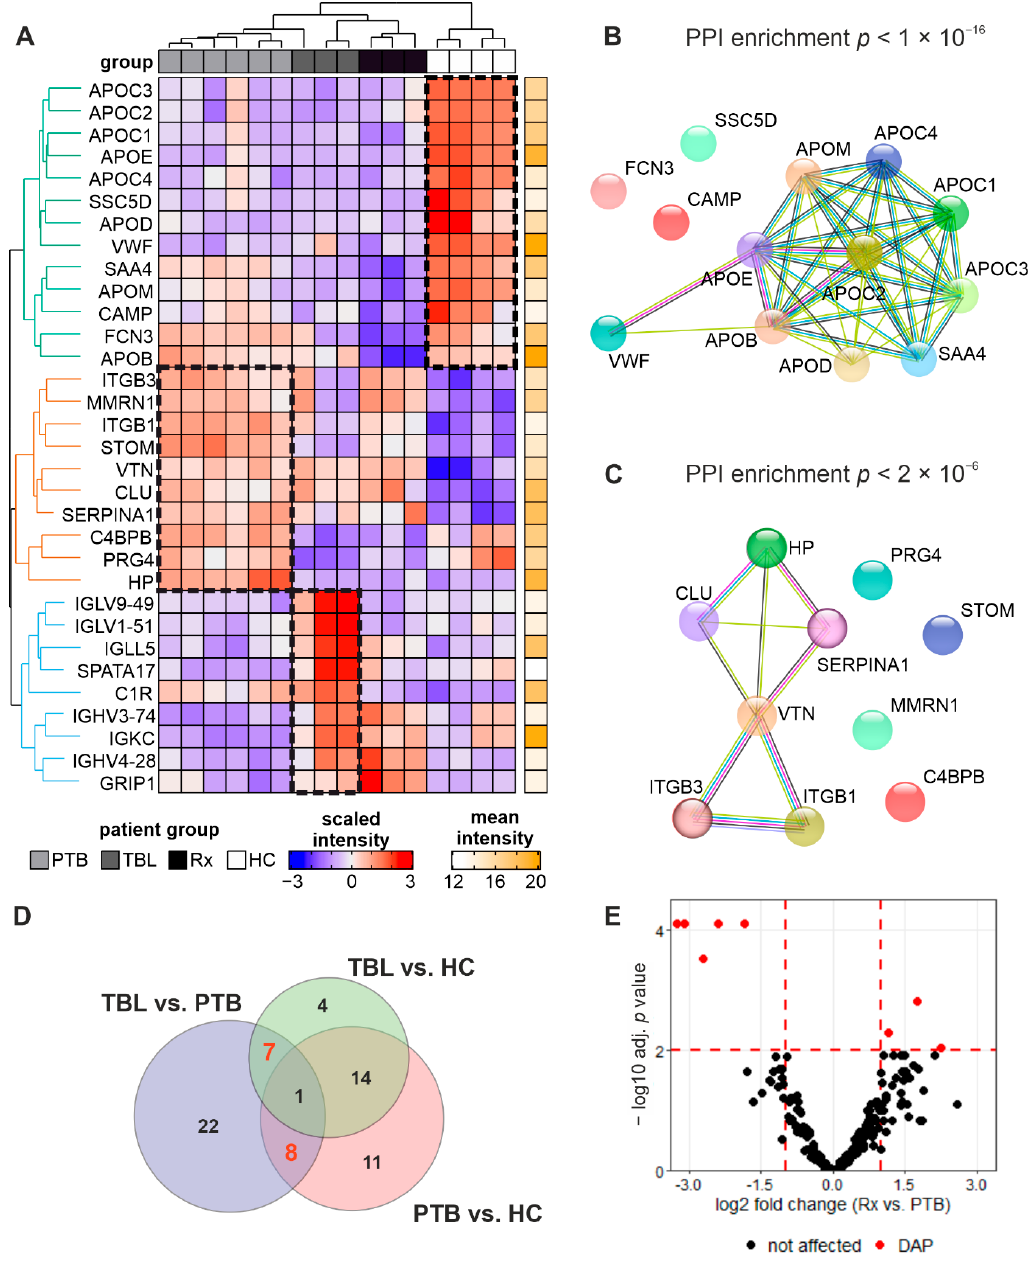
Figure 7. Disease and treatment state-specific protein composition. Comparative analyses of protein abundances at different disease and treatment stages were performed by tandem mass tag (TMT)- based quantification. Hierarchical clustering of ANOVA-revealed differentially abundant proteins (adjusted p < 0.01) resulted in a nearly perfect separation of the disease groups (columns) and grouping of proteins into three main branches (rows, branch 1 = green, branch 2 = brown, branch 3 = blue). Protein abundance values in heatmaps were scaled row-wise for visualization ( A ). Functional network analysis with STRING revealed significant protein–protein interaction (PPI) enrichments for proteins of main branch 1 ( B ) and main branch 2 ( C ). Stepwise pairwise analyses revealed 14 common, as well as eight and seven disease state-depending DAP as depicted in a Venn–Euler diagram ( D ). The Volcano plot represents treatment-affected DAP with log 2 -transformed ratios of protein abundances (Rx vs. PTB) and log 10 -transformed Benjamini–Hochberg-adjusted p values ( E ). HC—healthy controls, PTB—pulmonary tuberculosis, TBL—tuberculous lymphadenitis, and Rx—PTB after anti-TB drug